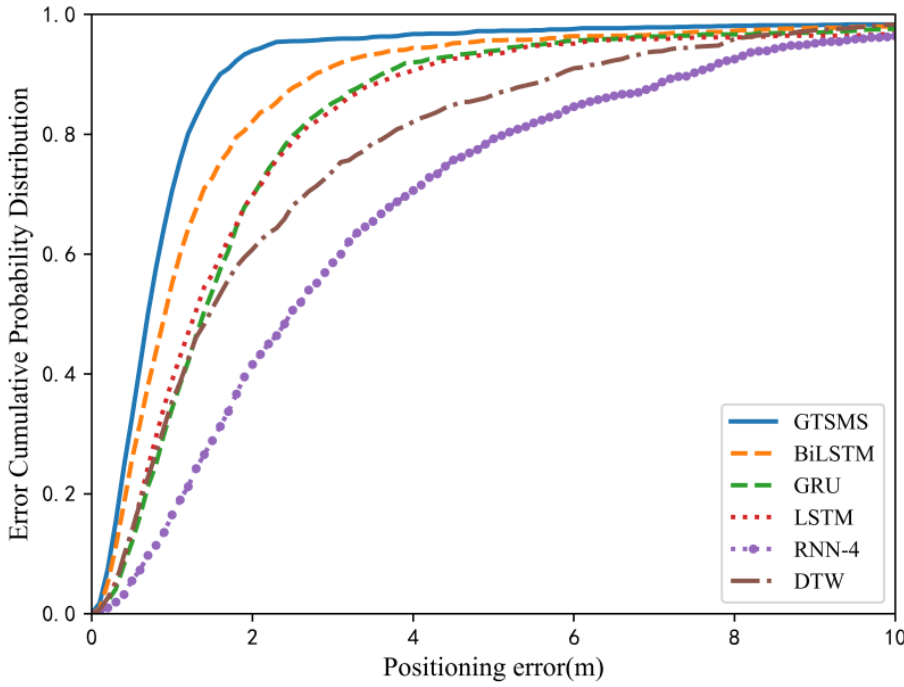
Figure 13. CDF of diverse location methods (GTSMS is the positioning strategy in this paper, and other methods are common positioning models and matching algorithms.).